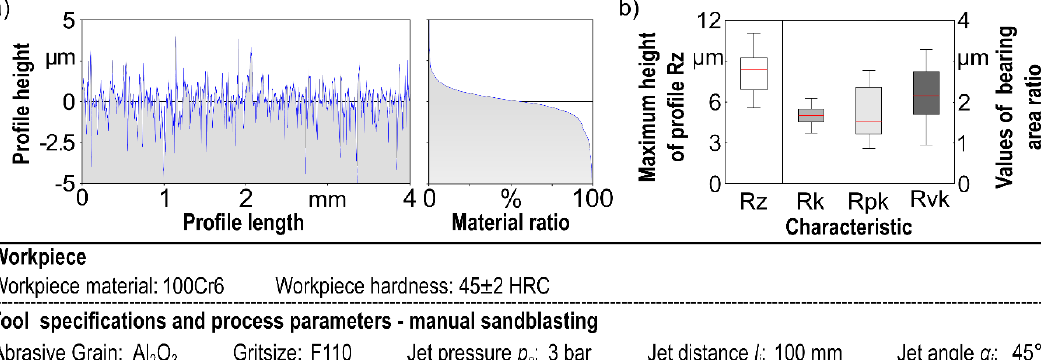
Figure 3. Overview of a sandblasted surface by means of ( a ) the profile and material ratio curve and ( b ) surface values.